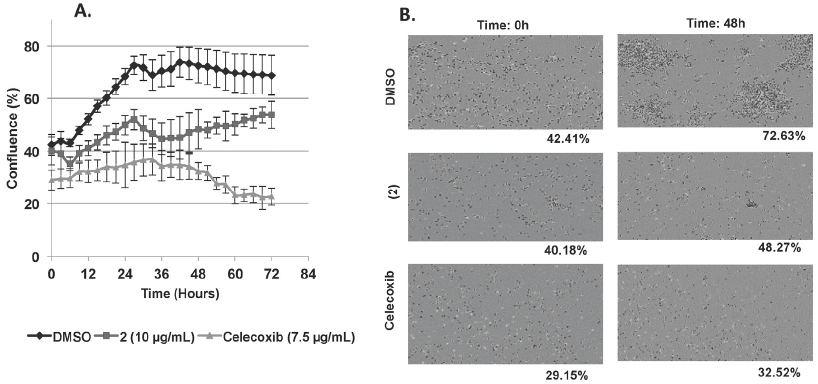
Figure 6. ( A , B ) Anti-proliferative effect of (2) at 10 µ g/mL on U937 cells was evaluated by Incucyte TM Live-Cell Imaging System and is presented here as U937 cells growth curve plotting confluence vs. time at six hour intervals ( A ); DMSO and Celecoxib (7.5 µ g/mL) were used respectively as negative and positive controls. Data are the mean ˘ SD (Standard Deviation) of three independent experiments with three samples per experiment. IncuCyte TM images of U937 confluence after 48 h of treatment with (2) versus DMSO and Celecoxib ( B